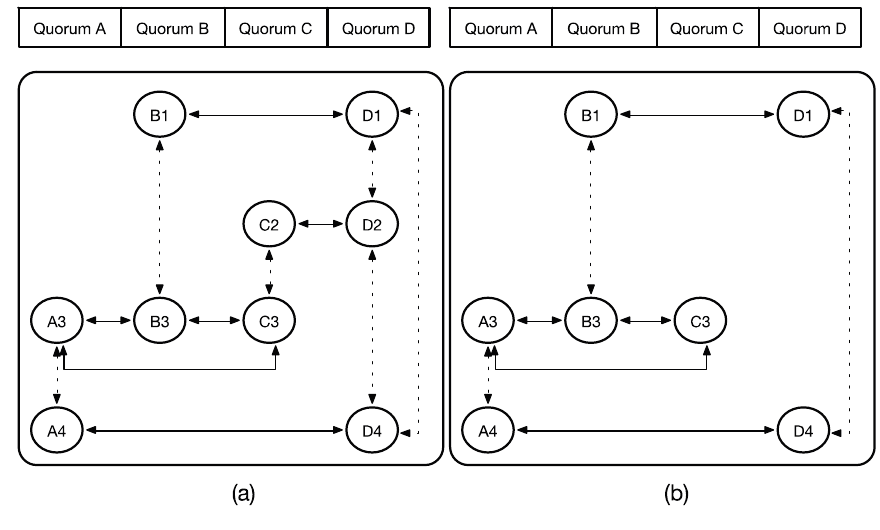
Figure 3. Example of ( a ) legacy quorum graph; and ( b ) extended quorum